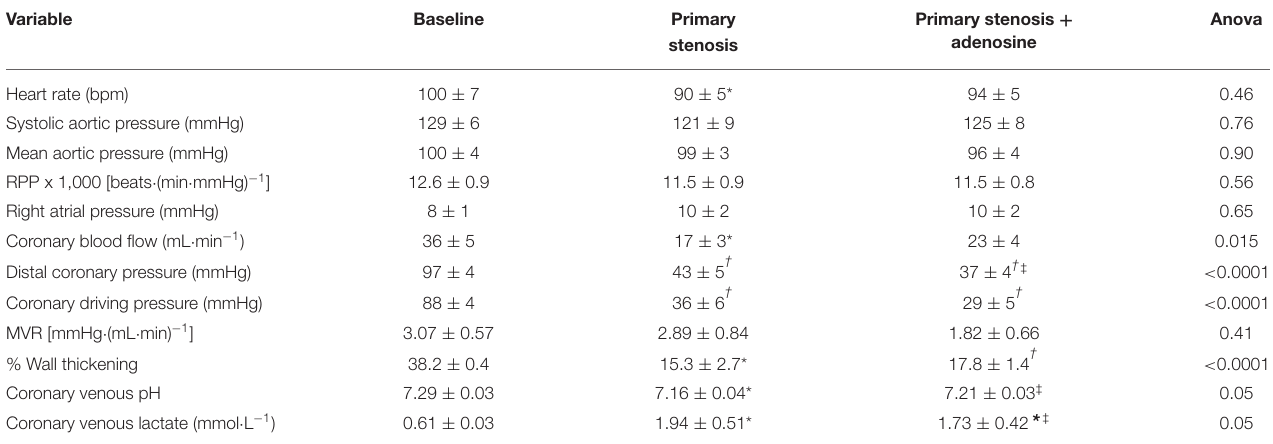
TABLE 1 | Primary stenosis results ( n = 9, mean ± 1SEM). Variable